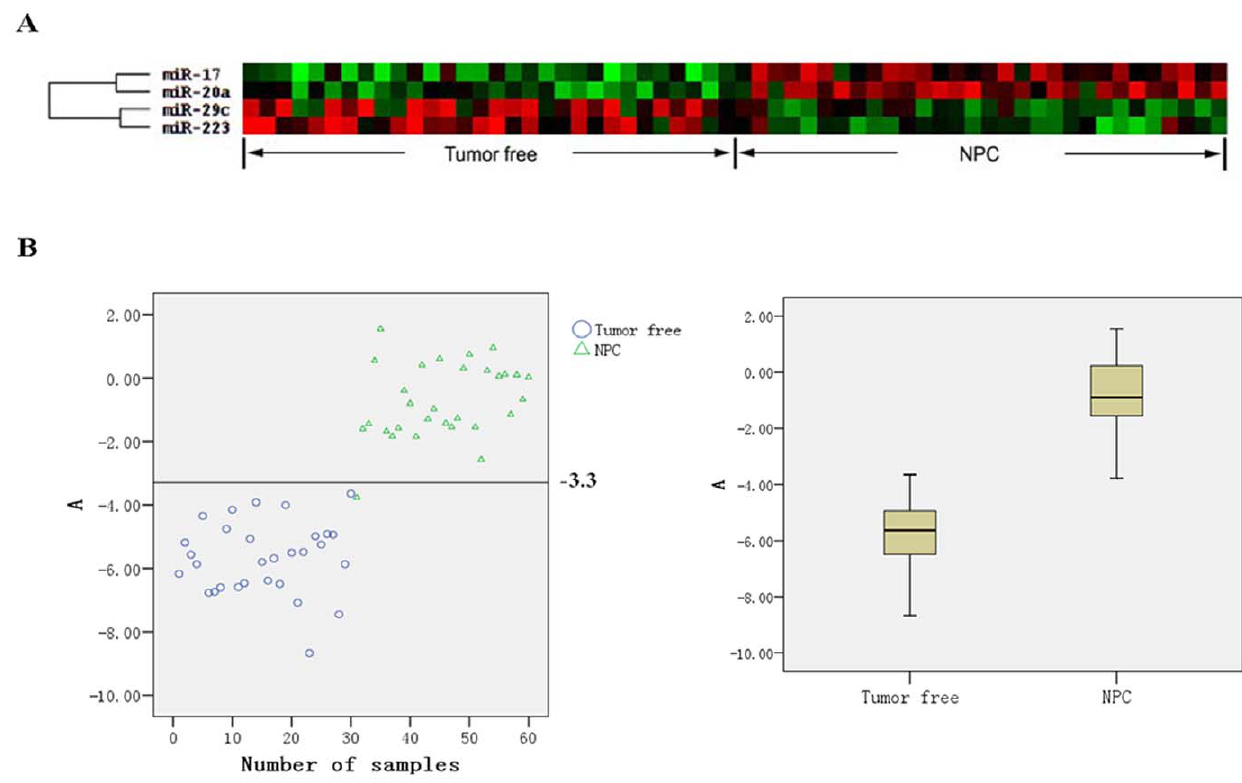
Figure 3. A: miR-17, miR-20a, miR-29c and miR-223 cluster analysis by Cluster 3.0 in 60 cases serum of NPC patients and non- cancerous control; B: A value distribution in 60 serum sample (Left: scatter; Right: Box). This shows that A value (=3.3) could discriminate the NPC patients and non-cancerous control well.